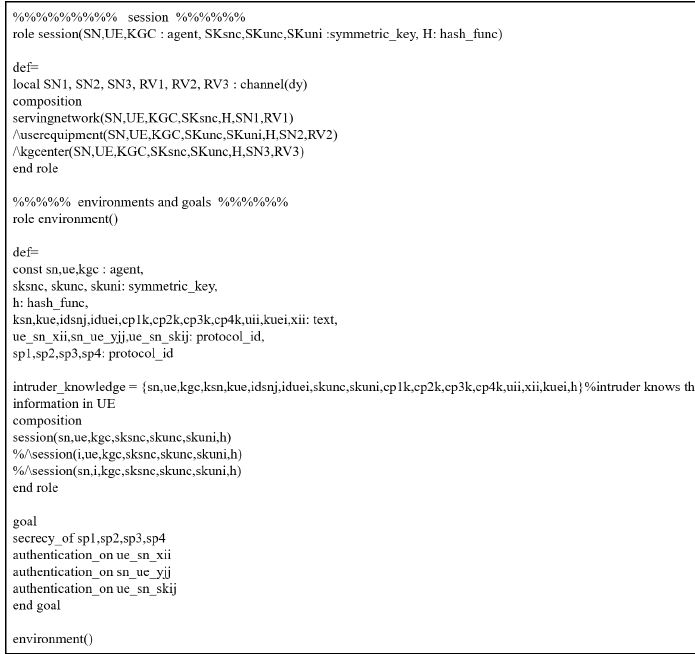
Figure 6. Scenario 1: HLPSL description of session and environment.